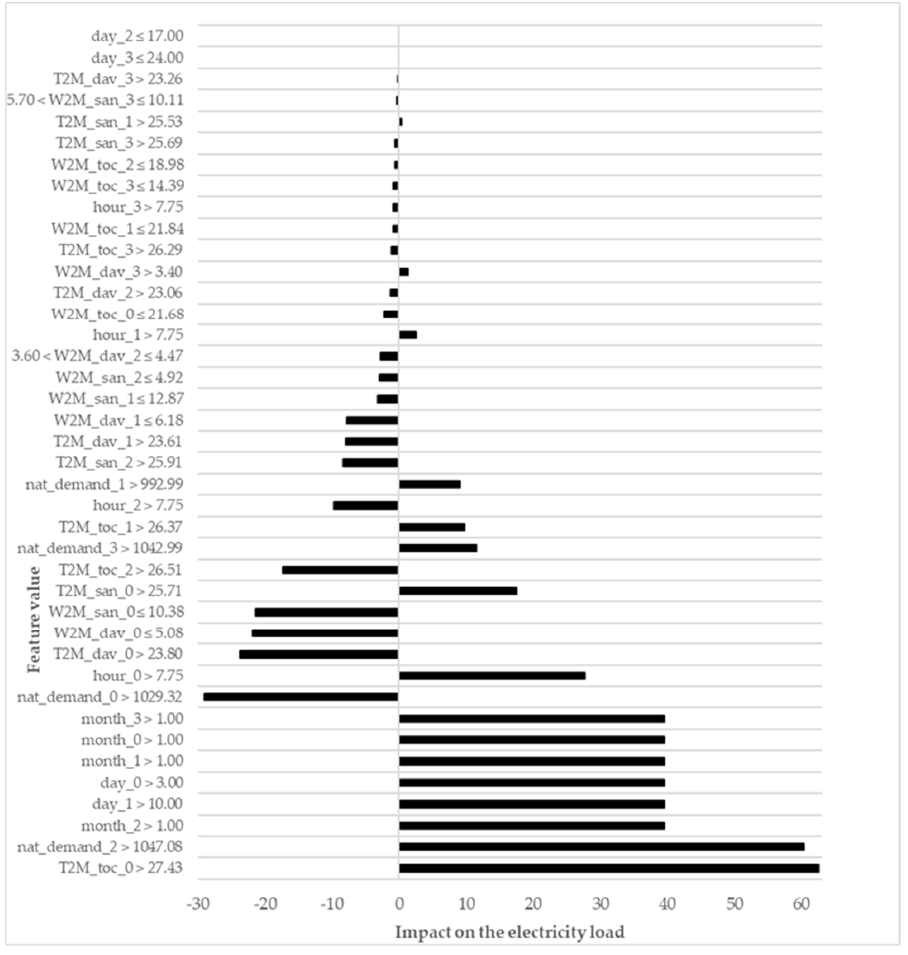
Figure 4. Explanations for LSTM and Fold 1 (experiment 2).